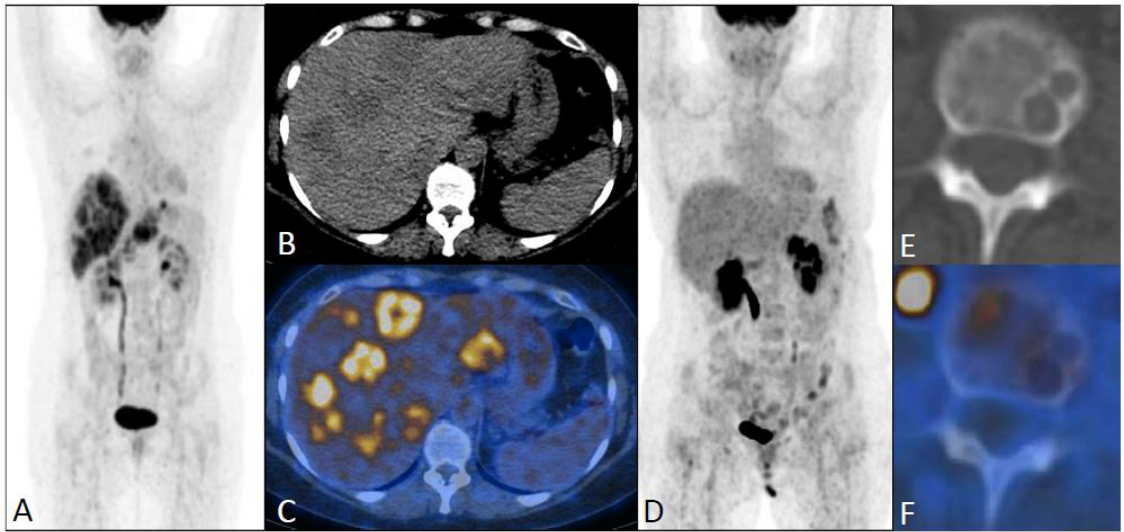
Figure 4. An FDG-PET/CT scan performed three years after the initial diagnosis of ILC (pT2N1, SBR II) in a 52-year-old patient treated by aromatase inhibitor, due to elevated tumor marker (CA 15.3 = 248). Maximum intensity projection ( A ), Axial CT ( B ), and PET/CT fusion ( C ) images showing metastatic spread to the liver, confirmed by biopsy. Maximum intensity